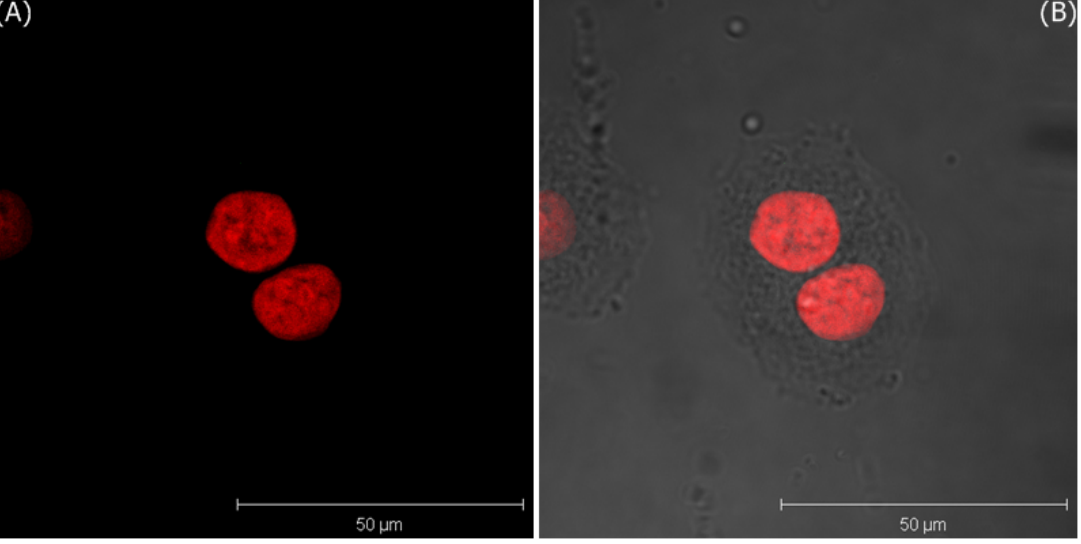
Figure 6. The 3D projection images of T-47D cells incubated with bare GNPs in media after 1 hour; A) LSCM image, and B) the merged image of LSCM and the phase contrast images.